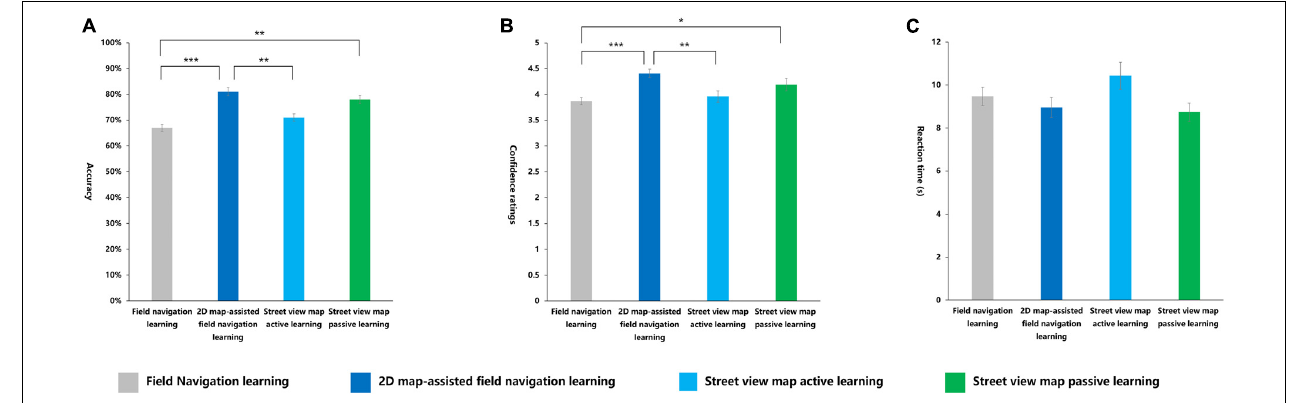
FIGURE 11 | Indexes in scene recognition task under four learning methods. (A) Accuracy, (B) confidence ratings, (C) reaction time (s). * p < 0.05; ** p < 0.01; *** p <